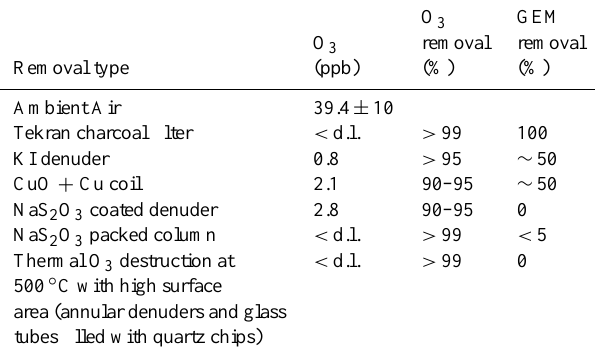
Table 2. Methods for removing O 3